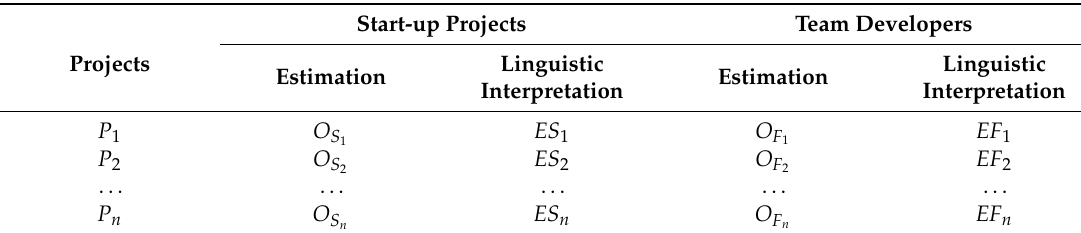
Table 1. Data for the case of a plurality of